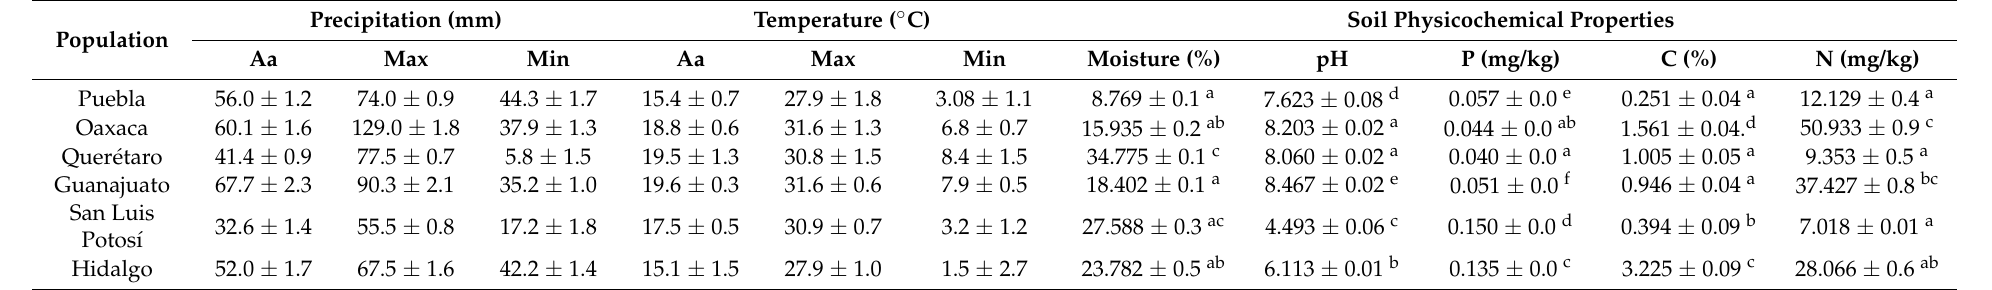
Table 4. Environmental variables of the natural habitats of wild populations of Brickellia